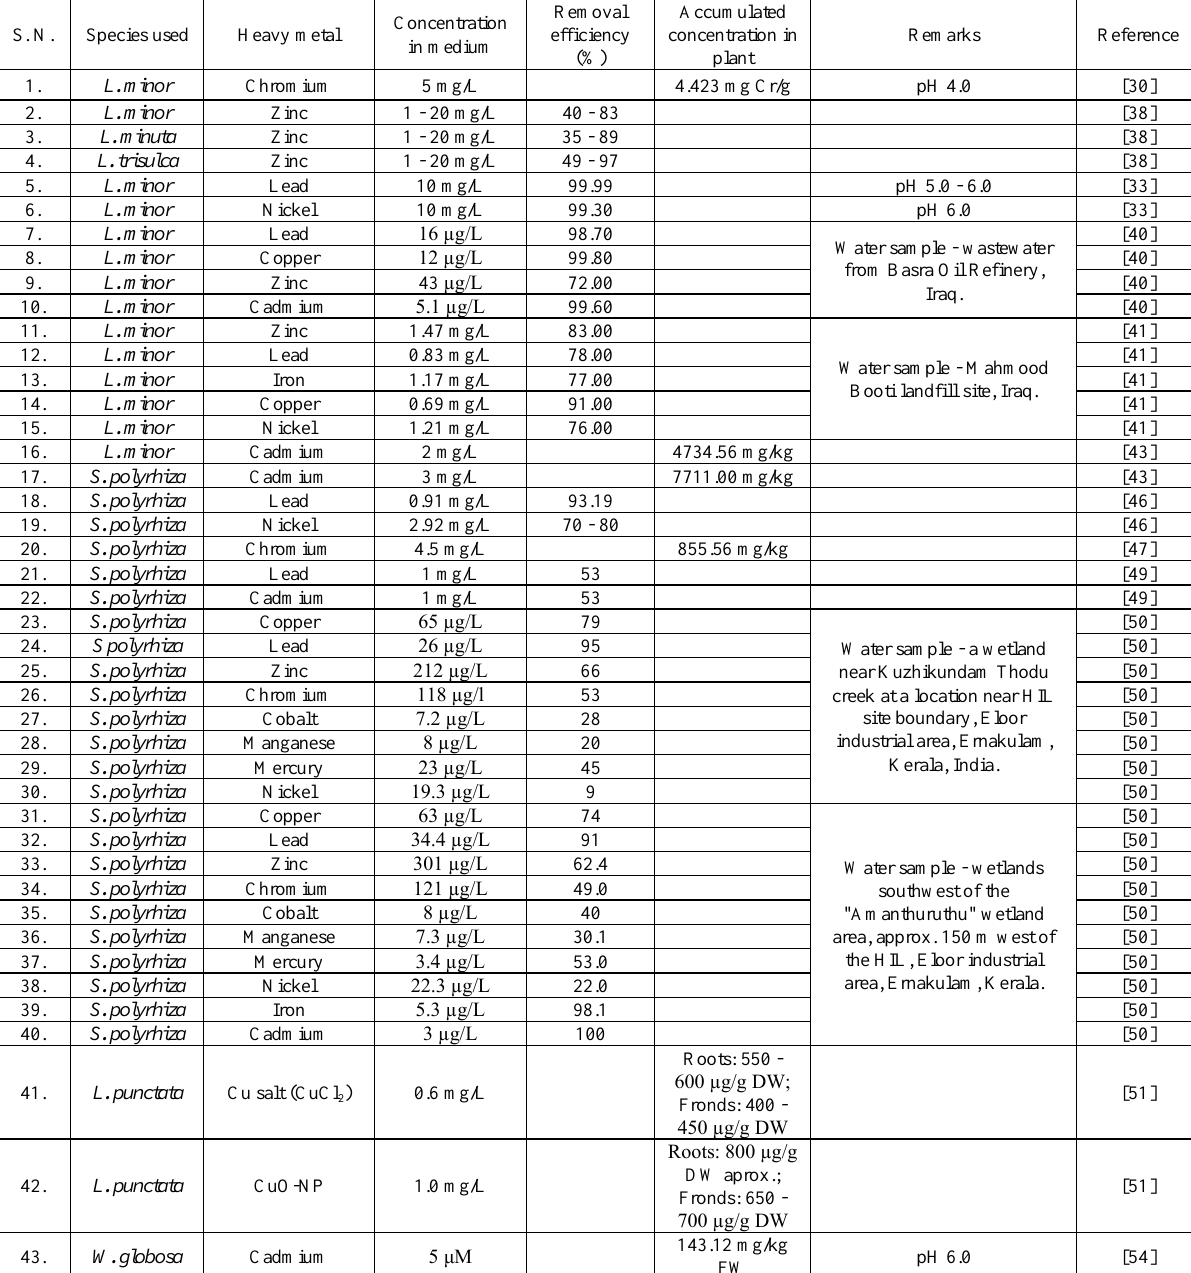
Table 1. Removal efficiency of duckweed for different heavy